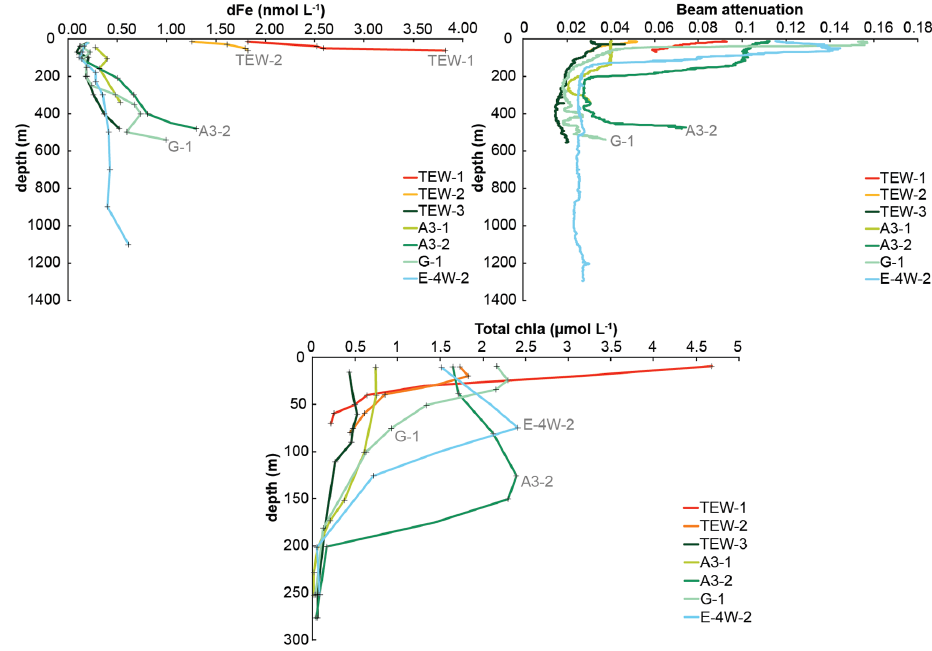
Figure 6. (a) Dissolved Fe concentrations, (b) beam attenuation coefficient, and (c) total chlorophyll a concentrations (from Lasbleiz et al., 2014) at near-coastal stations (cluster 1, TEW-1, and TEW-2), stations above the plateau (cluster 2, A3-1, A3-2, G-1, and TEW-3), and at E-4W-2. The same colour code as used in Fig. 1 applies